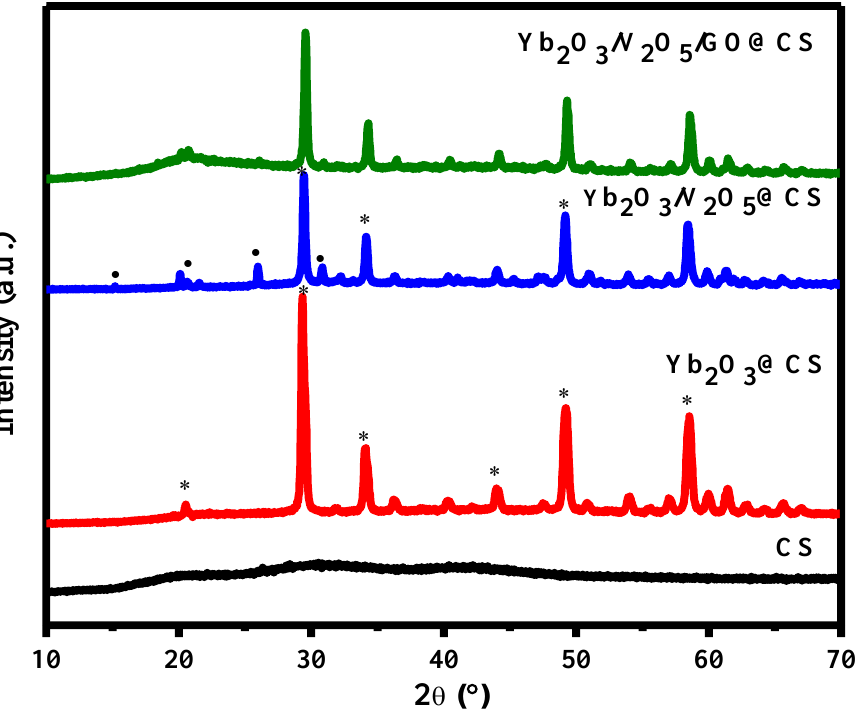
Figure 1. XRD of CS with different ratios of nanocomposites with Yb 2 O 3 and V 2 O 5 (* represents the peaks of V 2 O 5 , while the ● indicates the peaks of Yb 2 O 3 ).